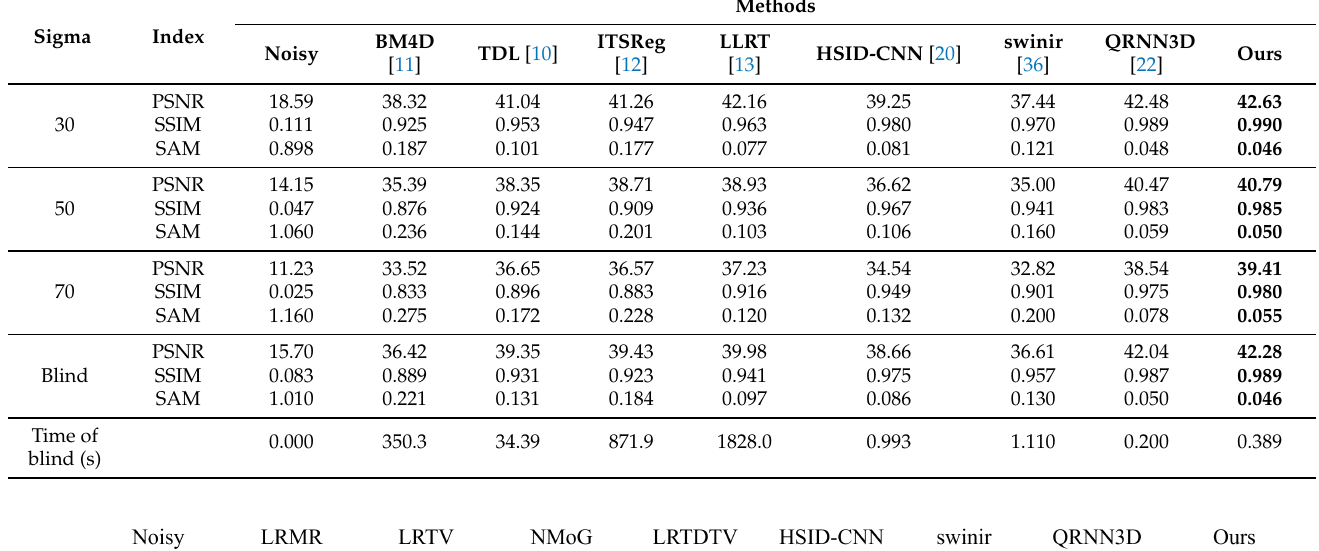
Table 2. The denoising results in the Gaussian noise case on the ICVL dataset.